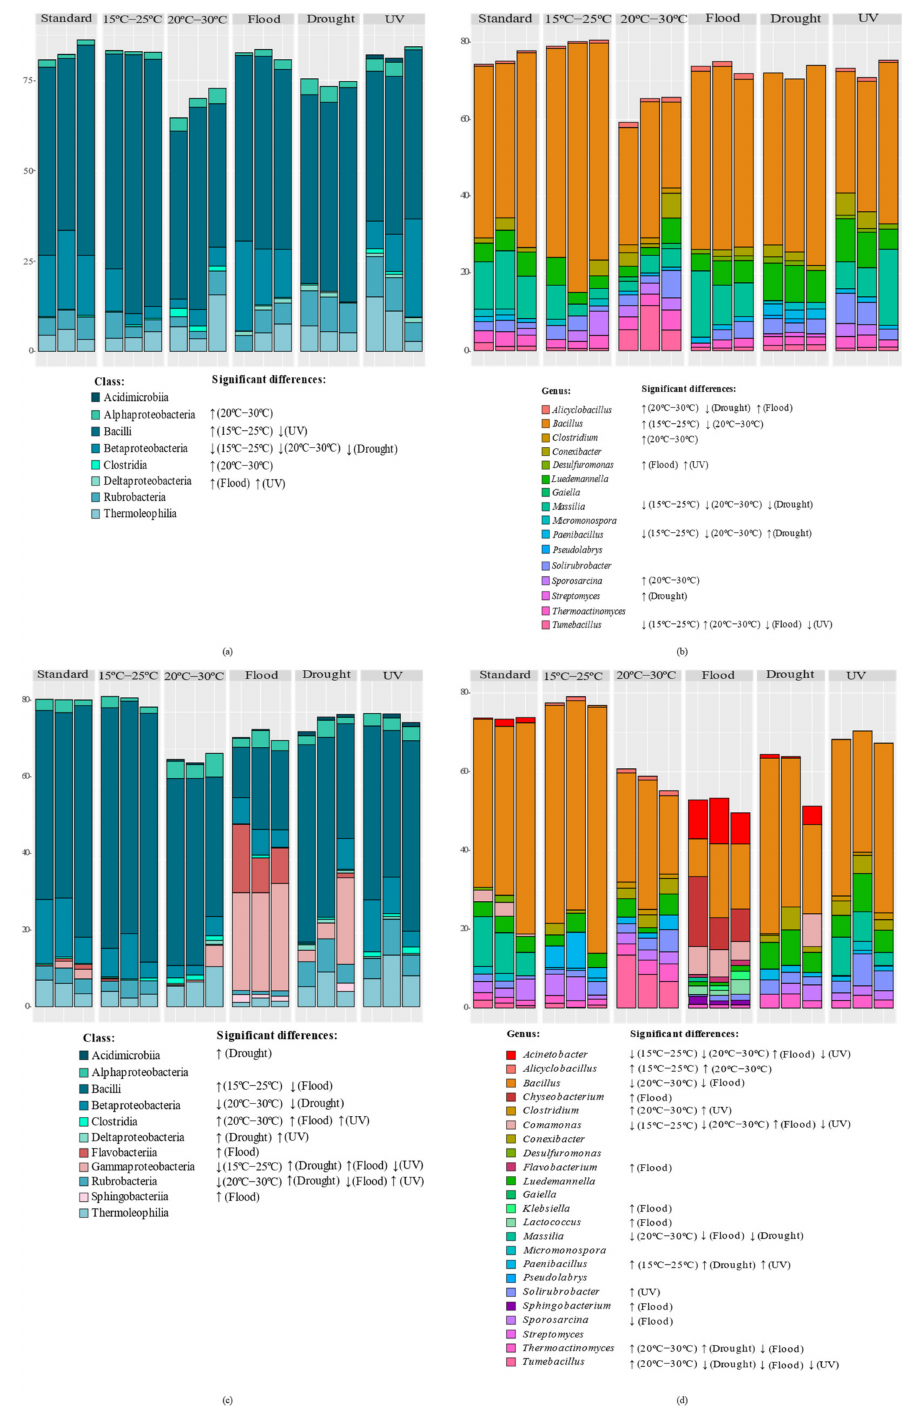
Figure 4. Relative abundance of bacterial classes ( a , c ) and 15 most abundant genera ( b , d ) of Lufa 2.2 soil without ( a , b ) and with ( c , d ) the presence of E. crypticus after exposure to each scenario for 48 h. Results from three replicates are presented. Standard refers to the conditions recommended by the standardized OECD guidelines. Arrows indicate significant differences ( ↓ decrease; ↑ increase) compared to standard conditions (one-way ANOVA followed by Dunnett’s post hoc test; p < 0.05). UV